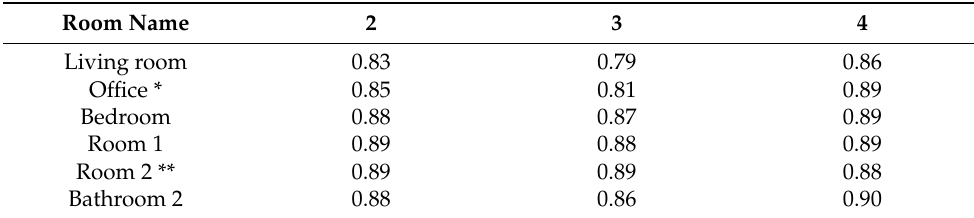
Table 7. Correlation coefficients R for measured and calculated hourly values for the entire mea- sured